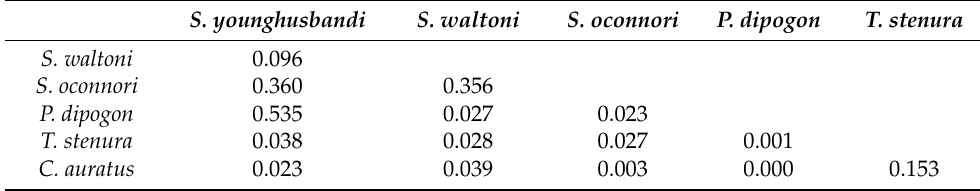
Table 3. Spatio-temporal niche overlap of main species in the Lhasa